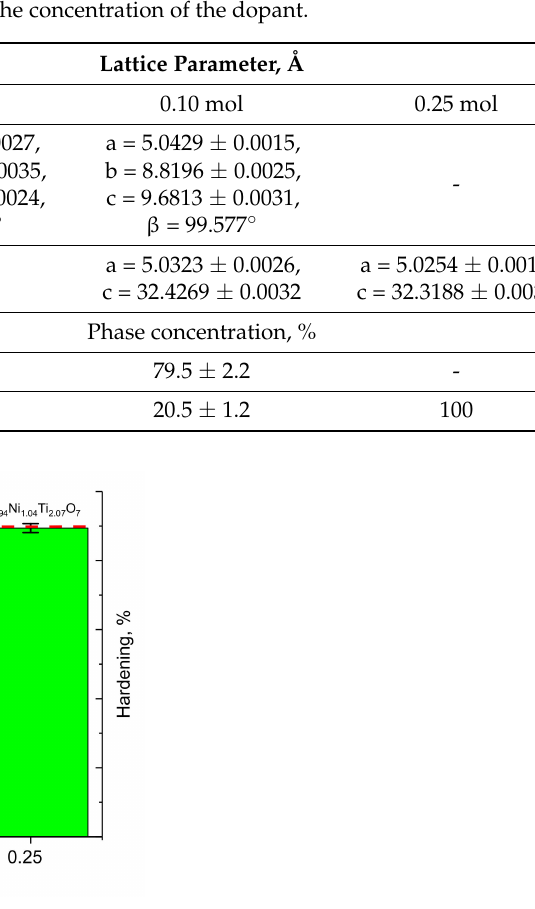
Figure 4. Diagram of the dependence of the change in the hardness of the studied ceramic on the concentration of the doping impurity. (Dashed lines show the values of the change in the hardening of the ceramic upon the addition of a